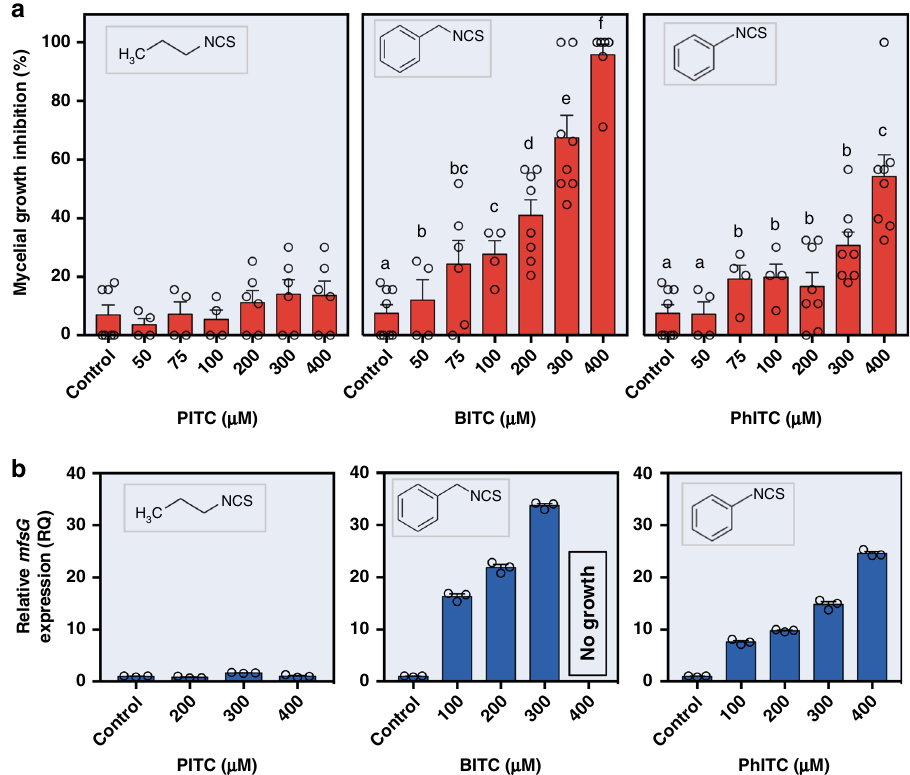
Fig. 1 Growth inhibition of B. cinerea and mfsG expression in response to ITCs. a Diameter of B. cinerea colonies was measured 48 h post inoculation on PDA plates supplemented with different concentrations of PITC, BITC or PhITC. Growth inhibition was calculated as percentage of colony diameter of B. cinerea grown on PDA with no ITCs. Data are displayed as mean values (± SE), n > 4. Different letters above the columns indicate signi fi cant difference at P < 0.05, as determined by Tukey – Kramer HSD test. b Expression of mfsG 72 h after exposure to different concentrations of PITC (left), BITC (middle) or PhITC (right), as determined by qRT-PCR, relative to expression on PDA without ITCs. n = 3. Source data are provided as a Source Data fi